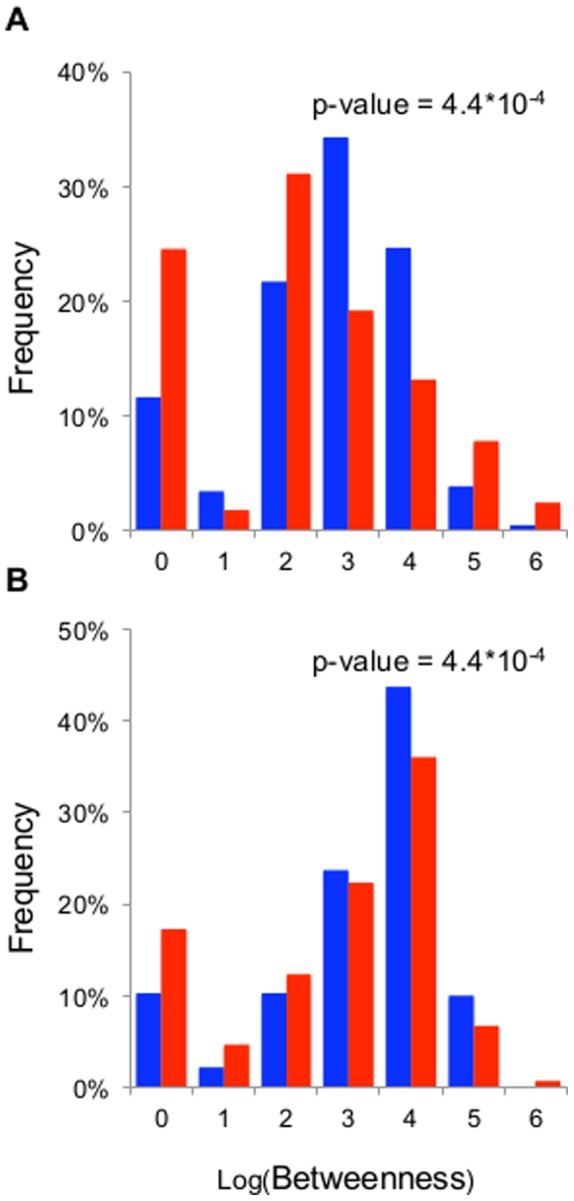
Histograms of the distribution of betweenness for alternatively spliced genes and genes with a single transcript.A, C. elegans. B, D. melanogaster. In blue, alternatively spliced genes. In red, genes with a unique transcript. P-values calculated using Mann-Whitney test and FDR correction for the equivalent comparisons.